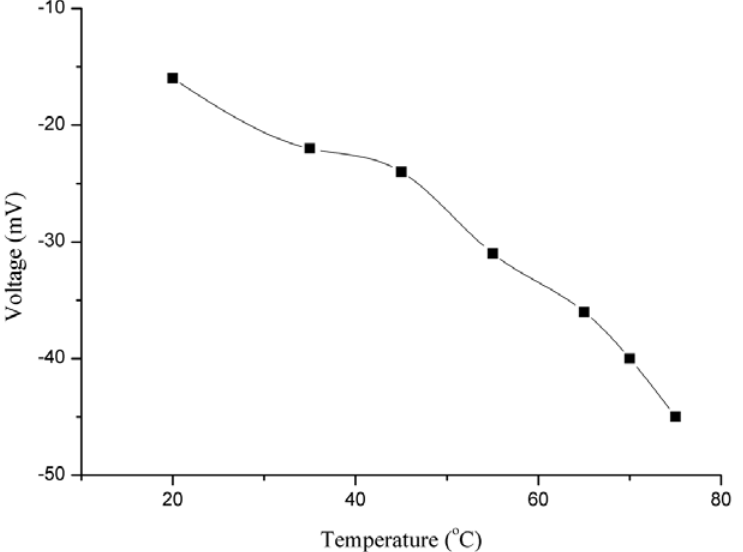
Figure 5. The temperature effect on the potential response of the iodide ion